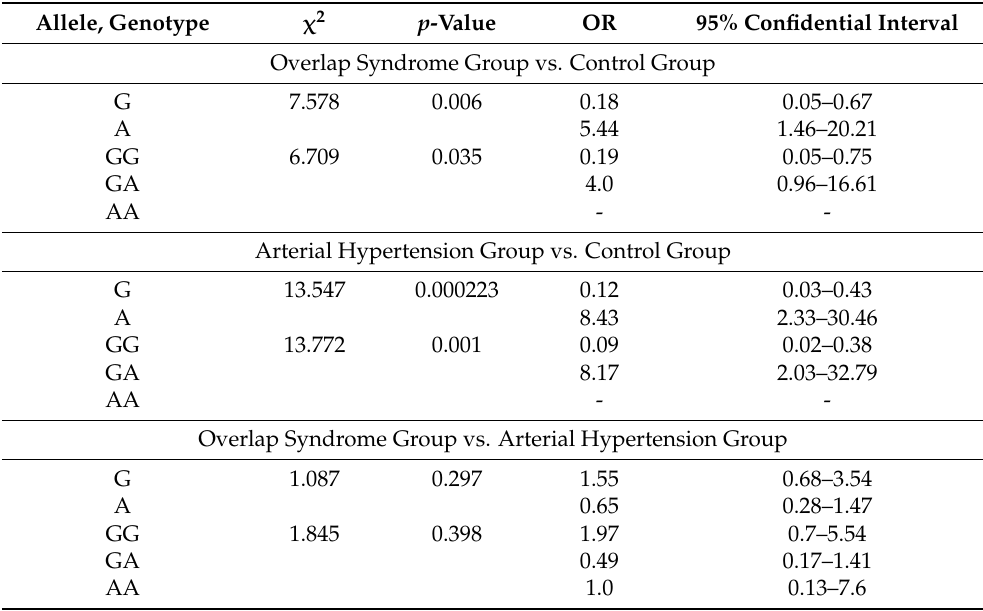
Table 4. Odds ratio (OR) of tension-type headache and arterial hypertension overlap syndrome depending on alleles and genotypes of rs2297518 of the NOS2 gene. Allele,